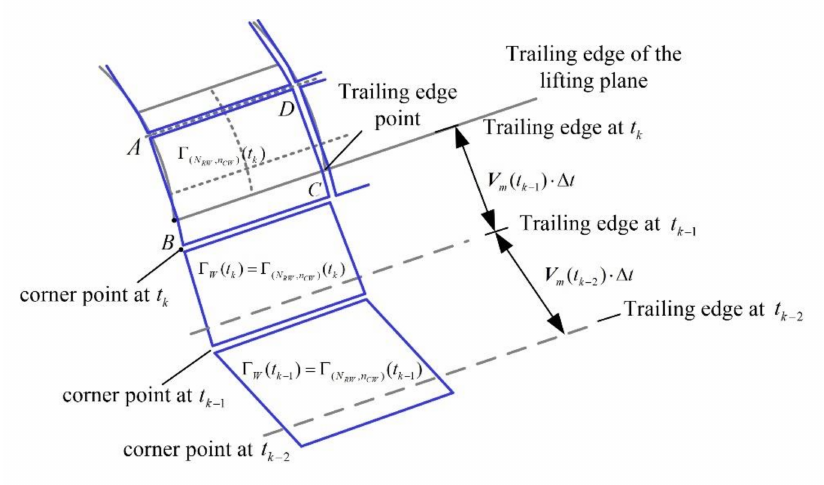
Figure 4. Unsteady motion of wake